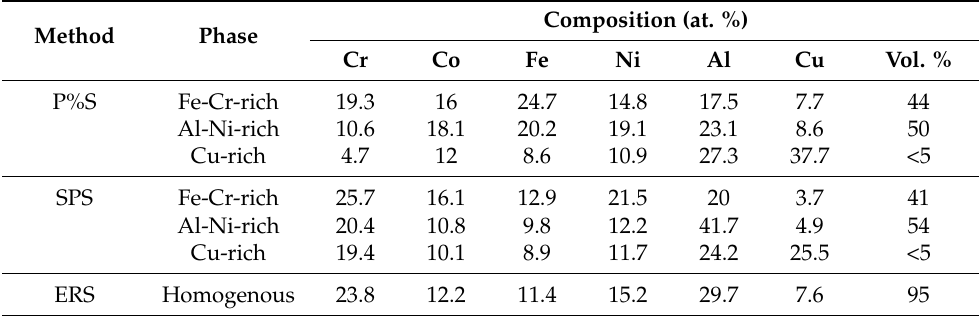
Table 3. Compositional and volumetric fraction analysis performed on the phases from mapping